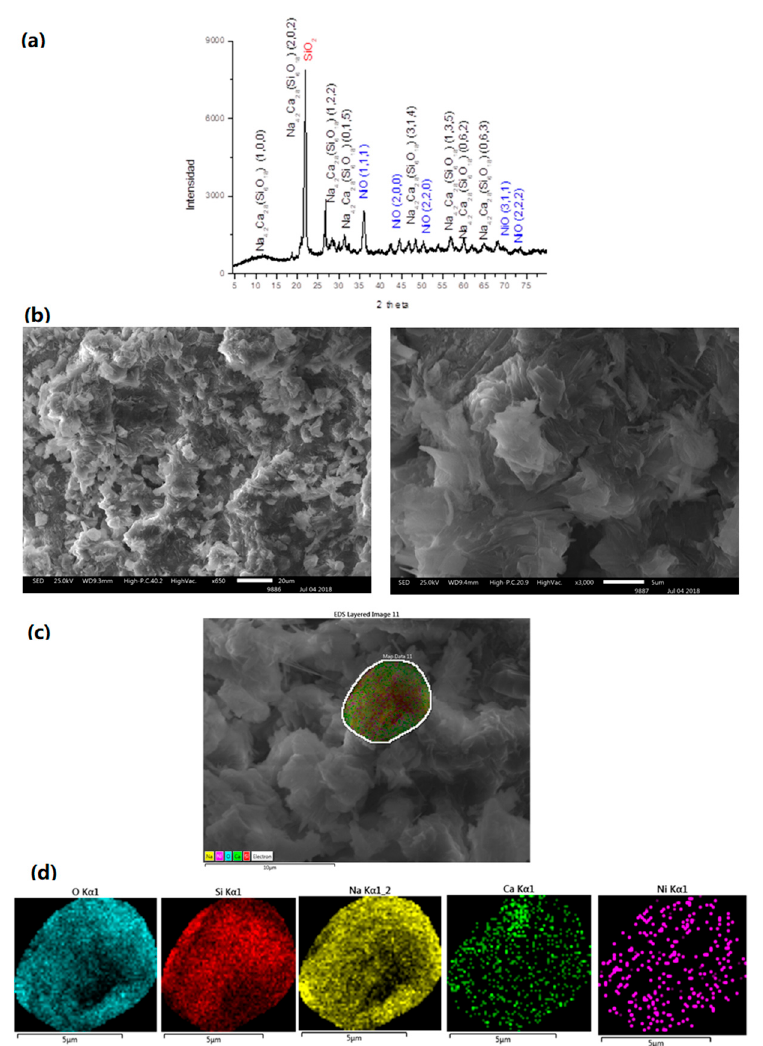
Figure 5. ( a ) XRD pattern of NiO inside Na 4.2 Ca 2.8 (Si 6 O 18 ); ( b ) and ( c ) SEM images; and ( d ) EDS mapping by an element of the composite NiO/Na 4.2 Ca 2.8 (Si 6 O 18 ).